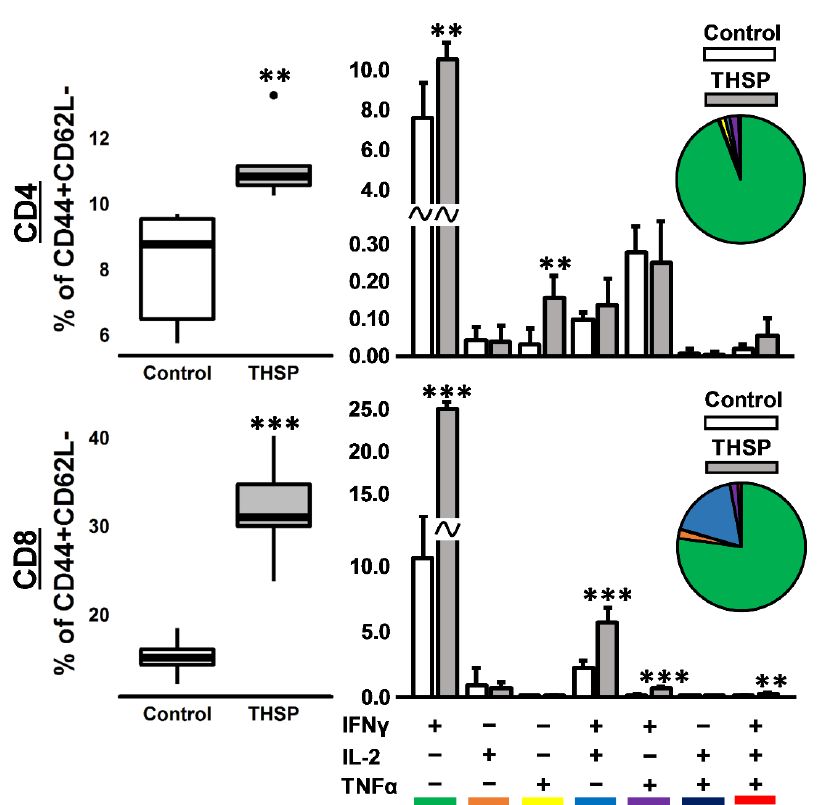
Figure 3. Immune response in mice after intranasal immunization with Flu/THSP recombinant virus. Antigen-specific effector memory T-cellular immune response in the spleen was assessed eight days after immunization by estimating the number of CD4/8+ CD44+CD62L- effector memory (EM) T-cells expressing IFN γ , IL-2, and TNF α after 24 h stimulation with BCG. Box plots represent the total amount of cytokine-producing EM T-cells. Bar-plots represent the average percentage of each cytokine-producing population within the total EM T-cells subset ± SD. Pie charts show the average percent of each cytokine-producing population within a total subset of cytokine-producing cells. The differences between groups were analyzed using the Student’s t -test (** p < 0.01, and *** p < 0.001, n =